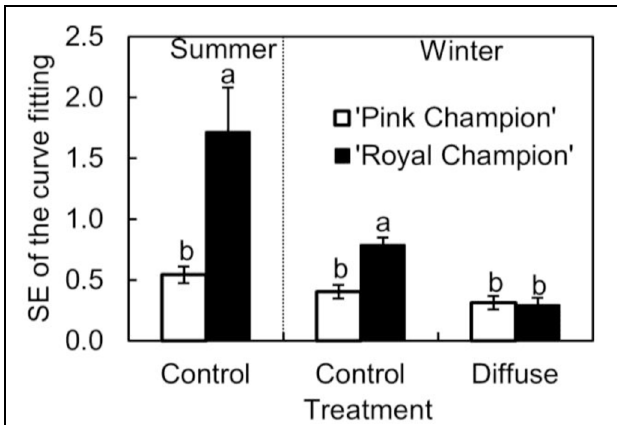
FIGURE 5 | Standard error of fitting non-rectangular hyperbola to instantaneous net leaf photosynthesis rates as a function of incident PPFD (Eq. 2) in summer growing season in the control treatment ( n = 3), and in winter growing season in the control as well as in diffuse light treatments ( n = 4; as see in Figure 4 which shows one replicate under each specific condition). Data used for curve fitting in this figure were collected on clear days. Error bars show ± SE. Letters within each growing season show statistical significant differences ( P <